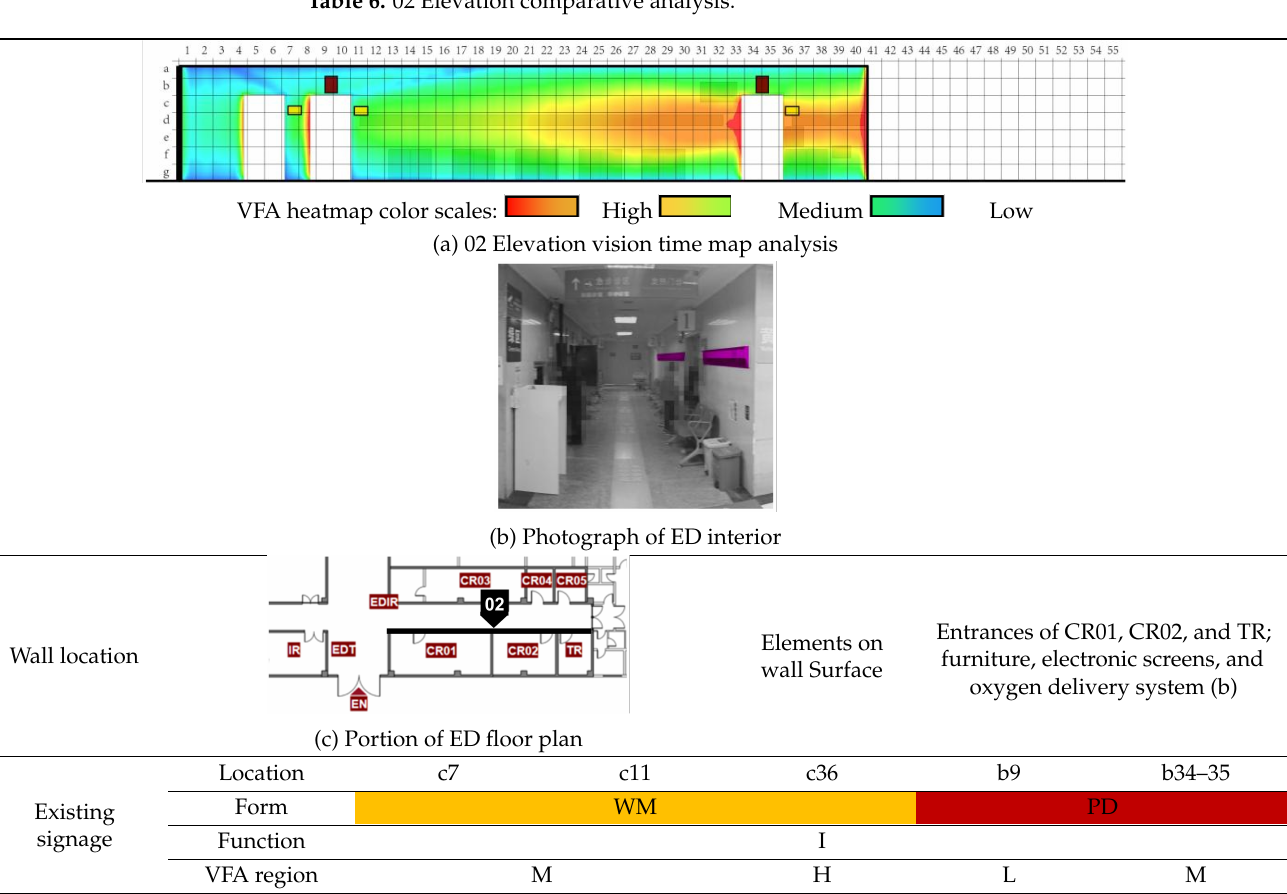
Table 6. 02 Elevation comparative analysis.